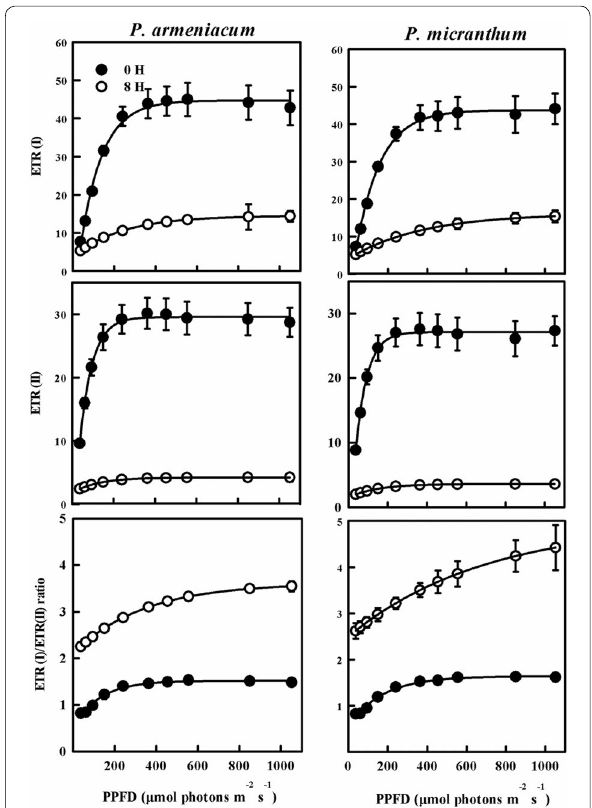
Fig. 10 Light‑response changes in photosynthetic electron flow through PSI (ETRI) and PSII (ETRII), and ETRI/ETRII ratios in leaves from two species of Paphiopedilum after 8 h chilling stress. Mean calculated from six independent plants per